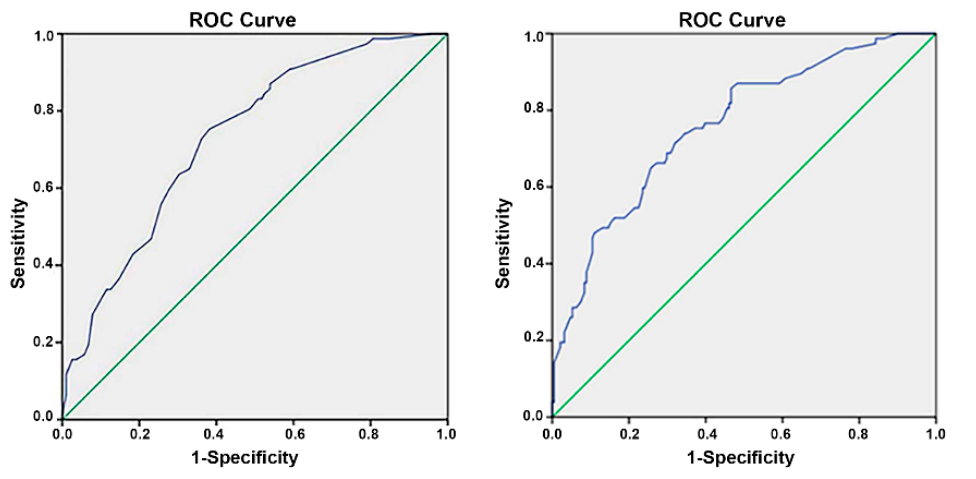
Figure 1. ROC (receiver operating characteristic) curve and AUC (area under the curve) of logistic regression Model 1 ( left ) and Model 2 ( right ).